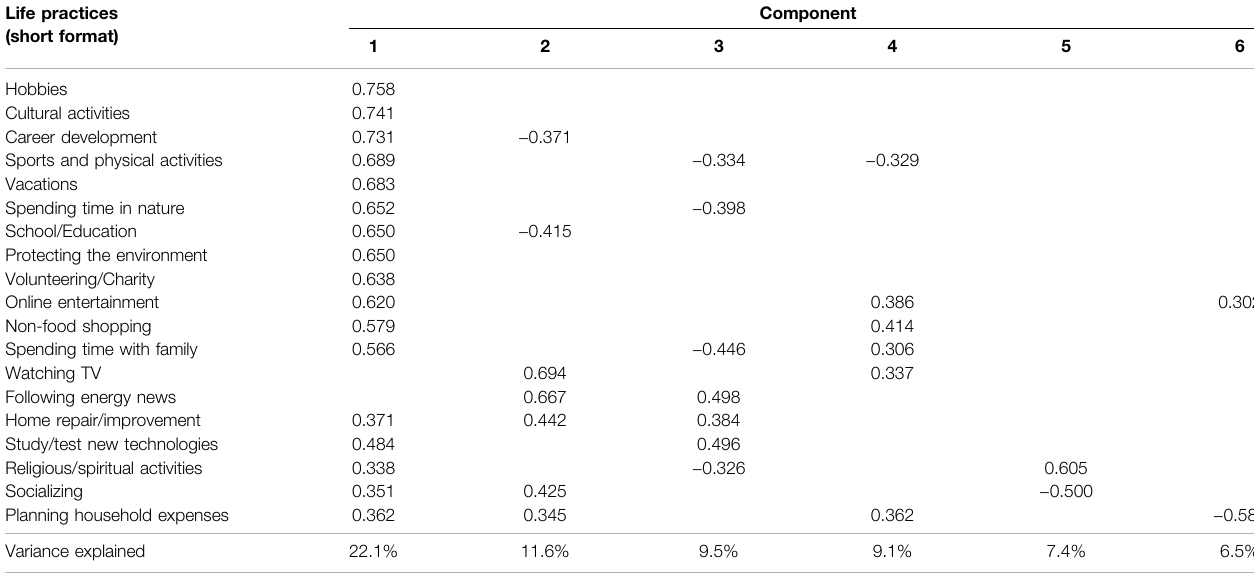
Variance explained